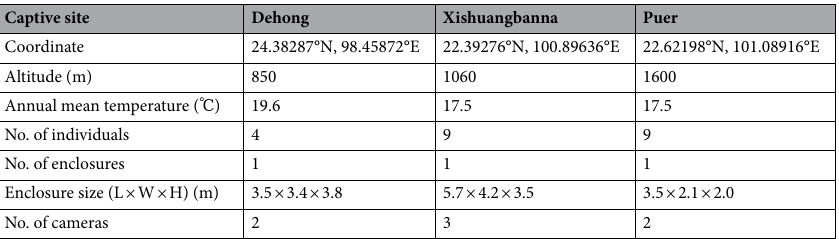
Table 1. Enclosure characteristics of each captive site for video data collection.